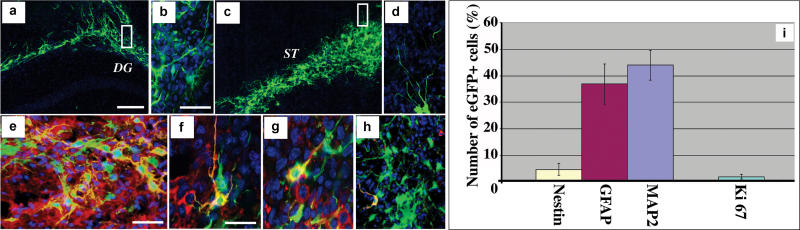
NS Cells Incorporate and Differentiate within the Adult Brain(A–H) Confocal images of LC1 NS cells, lentivirally transduced with enhanced GFP, 4 wk post-grafting into hippocampus (A,B) or striatum (C–H). (B) and (D) show higher magnification of the insets in panels (A) and (C), respectively. Examples of enhanced GFP grafted NS cells (green) showing co-expression (yellow) of the neuronal markers TuJ (E, red) or MAP-2 (F, red), astroglial marker GFAP (G, red), neural progenitor marker nestin (H, red).(I) Quantitative analysis of graft-derived neuronal (MAP2), astroglial (GFAP), progenitor (Nestin), and proliferating (Ki67) cells, 4 wk after transplantation into adult mouse striatum. Data are means (± standard deviation) of at least 500 enhanced GFP+ cells from five independent animals. DG, Dentate Gyrus; ST, Striatum. Scale bars: A,C, 100 μm; B, D, E, 40 μm.; F–H, 20 μm.